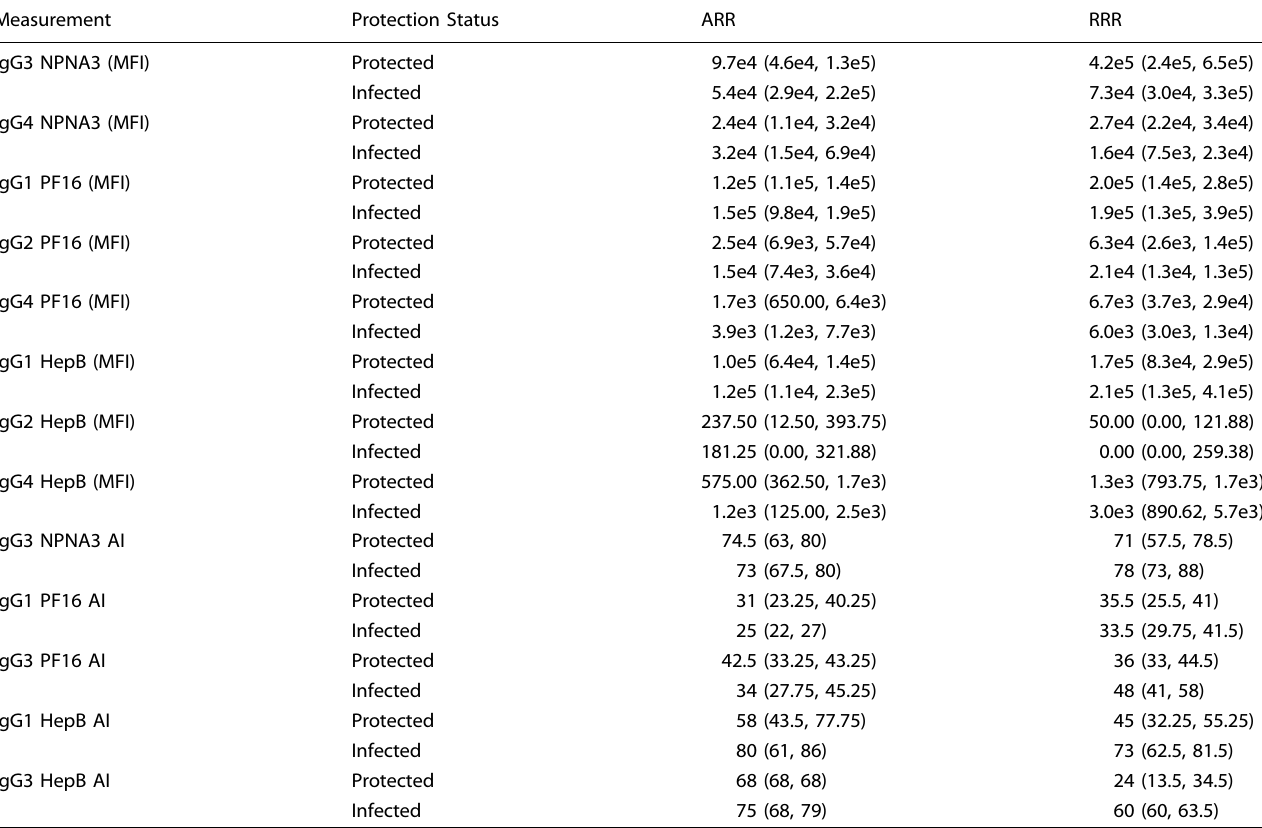
Table 2. Descriptive statistics for subclass measures in MAL-068 vaccinees which were not measured in MAL-071.